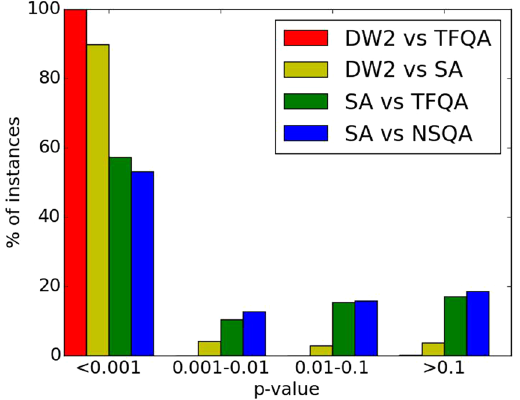
Figure 3. The p -values generated by the Kolmogorov-Smirnov tests to quantify the differences between pairs of